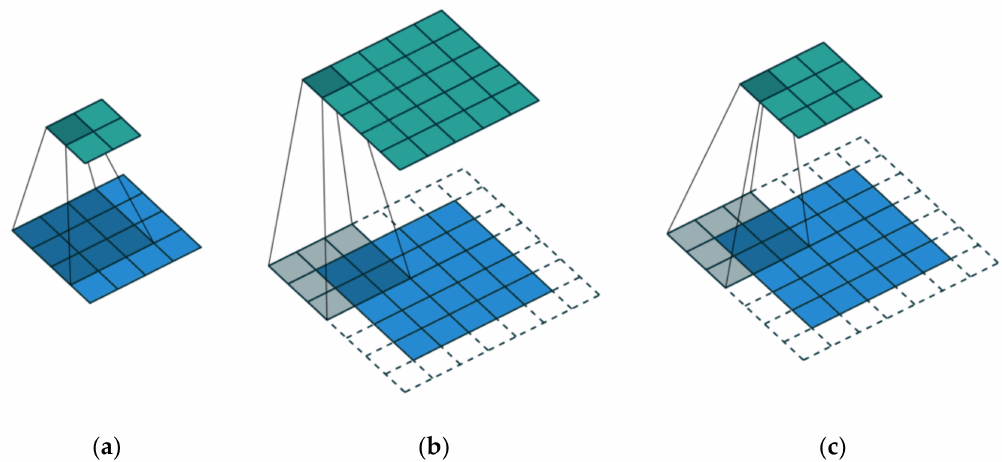
Figure 2. Impact of stride and zero-padding on data dimensions, showing input data in blue, the filter kernel as the shaded area over the input data, and the output data in green: ( a ) a stride of 1 is used whereas zero-padding is not used, causing the data dimensions to shrink; ( b ) a stride of 1 is used along with zero-padding (dotted elements), keeping the output data dimensions the same of those of the input; ( c ) a stride of 2 is used, causing the data dimensions to shrink by half